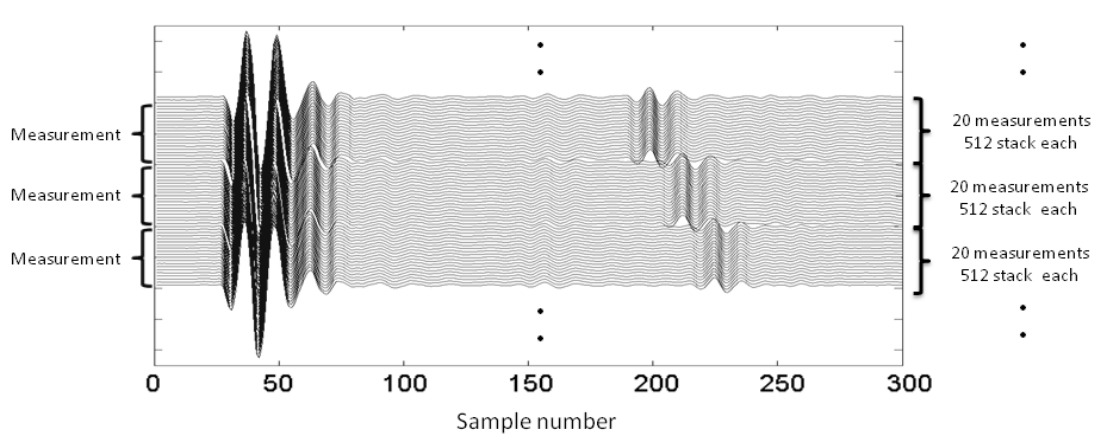
Figure 6 . Example of measurements performed at different distances. For each distance, 20 measurements with 512 stacking each were obtained. Amplitude variations between measurements are close to 1%, whereas arrival time variations are practically